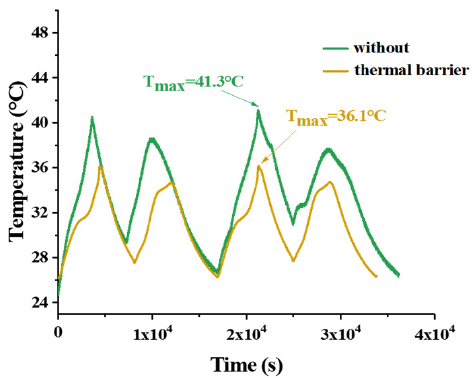
Figure 11. Temperature of the battery at a 100 A charging